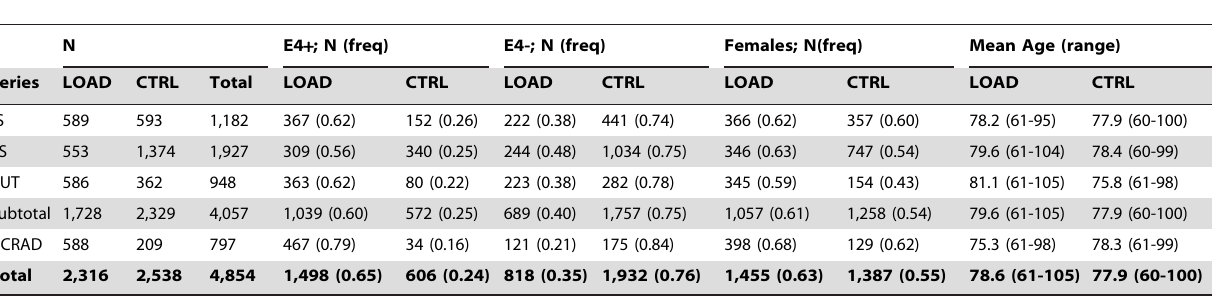
Table 1. Details of samples used in this